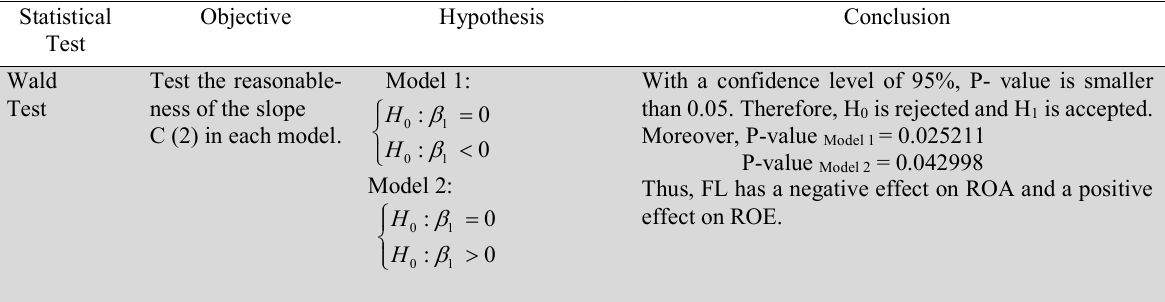
Process validation of the rationality and reliability of regression models